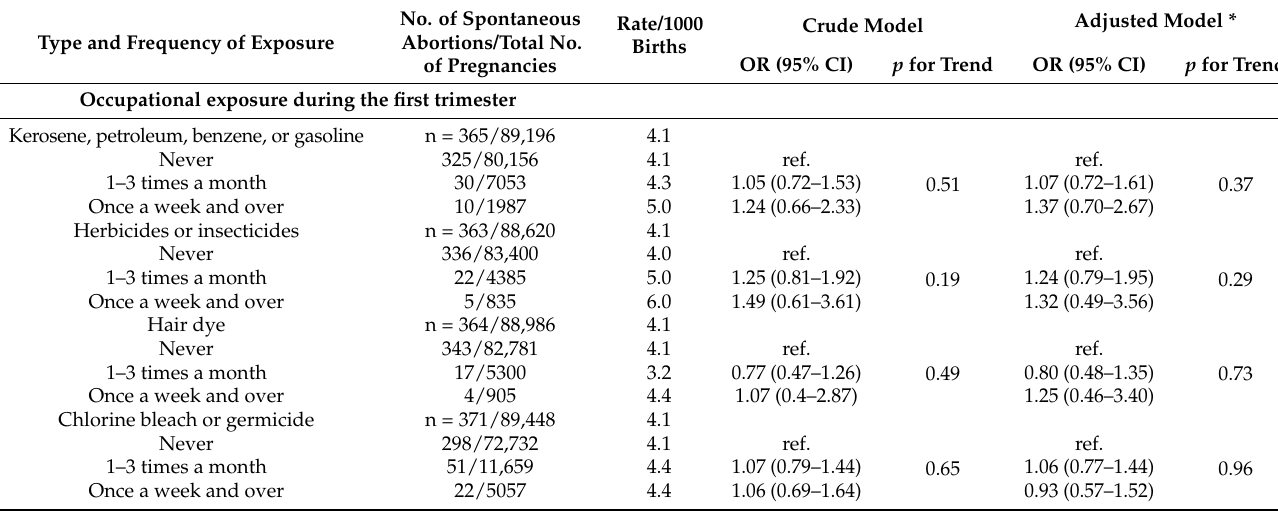
Table 2. Adjusted odds ratio of spontaneous abortion occurrence for occupational exposure during the first trimester. No. of Spontaneous Abortions/Total Type and Frequency of Exposure